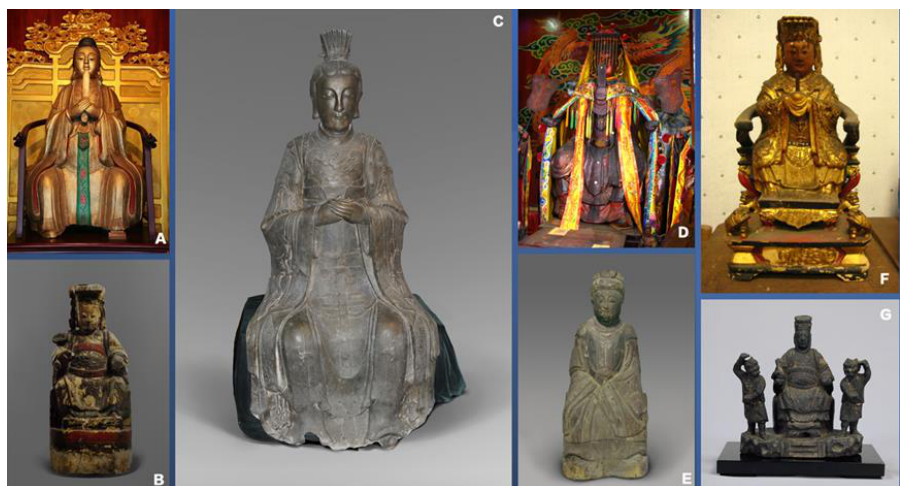
Figure 10. The image of Mazu in three-dimensional statues since the Ming and Qing dynasties (( A ) Bronze Statue of Mazu in Xianying Palace, Temple Island 廟 島 ; ( B ) The painted wooden statue of Mazu in the early Qing dynasty in the Tianhou Palace, Lukang, Taiwan; ( C ) The bronze statue of Mazu in the Ming Dynasty collected by Nantong 南 通 Museum; ( D ) Hard-bodied Mazu statue at Kaiji 開 基 Tianhou Temple, Tainan City, Taiwan; ( E ) Carved wooden statue of Mazu in Zhenlan Temple, Dajia, Taiwan; ( F ) Statue of Mazu from Laoshen Tang 老 神 堂 , Tainan City, Taiwan; ( G ) Statue of Mazu in Qing dynasty in Japanese Museum). Source: Photographed by the